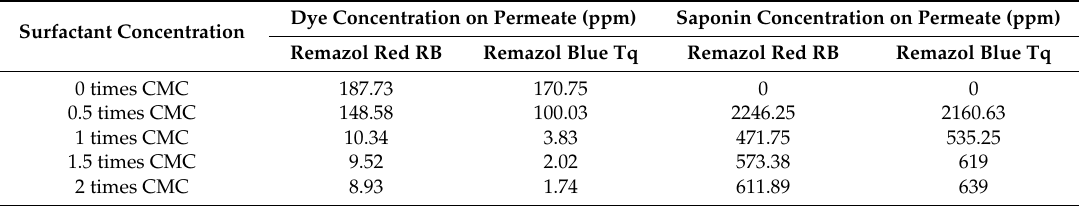
Table 2. Concentration of dye and saponin on the permeate after membrane